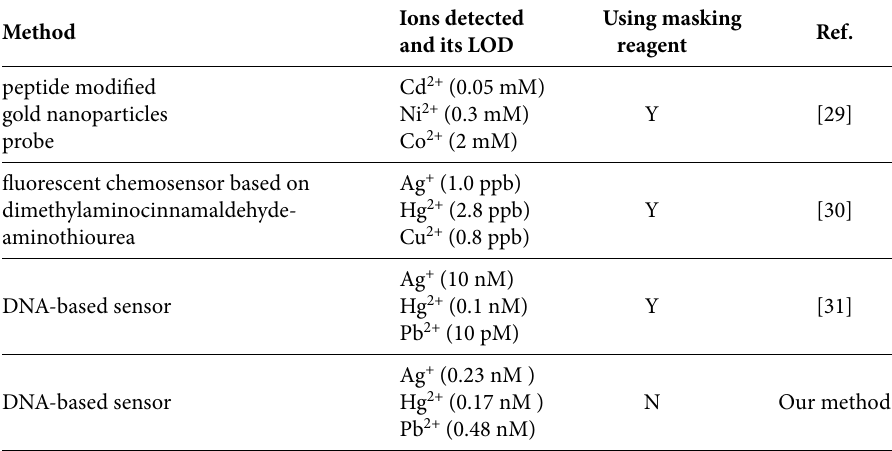
Table 1. The comparison of our sensor with other methods for simultaneous determination of three metal